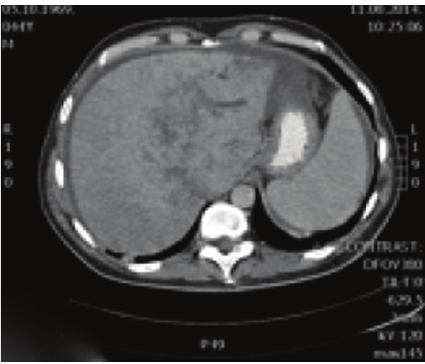
Figure 7: In portal venous phase, peripheral part of the liver lesion became washed out, except in the central hypodense